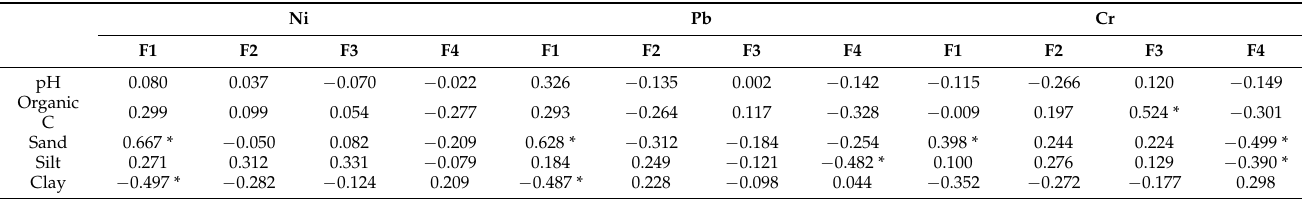
Table 4. Correlation coefficients between characteristics of studied soils and fractions of Ni, Pb, Cr; sand (2–0.05 mm), silt